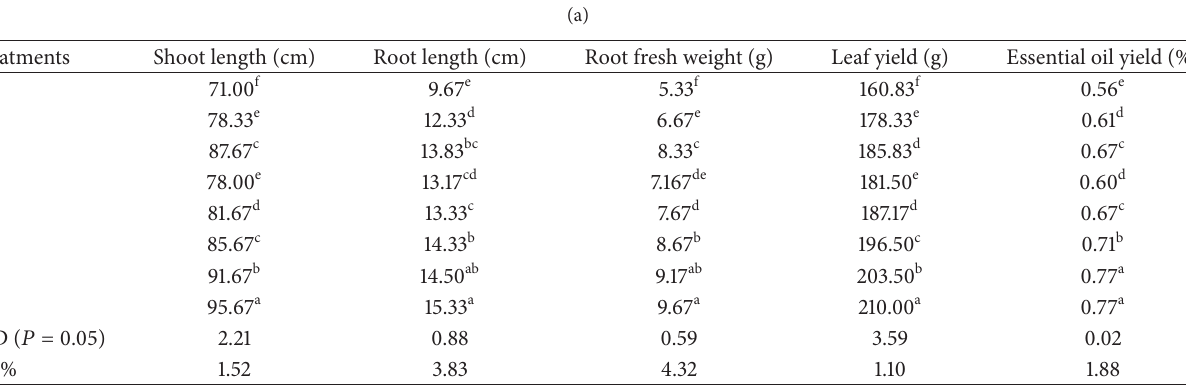
Table 2: (a) Relation between plant biomass and percentage essential oil in O. tenuiflorum cv. CIM-Ayu. (b) ANOVA table for biomass and percentage essential oil.